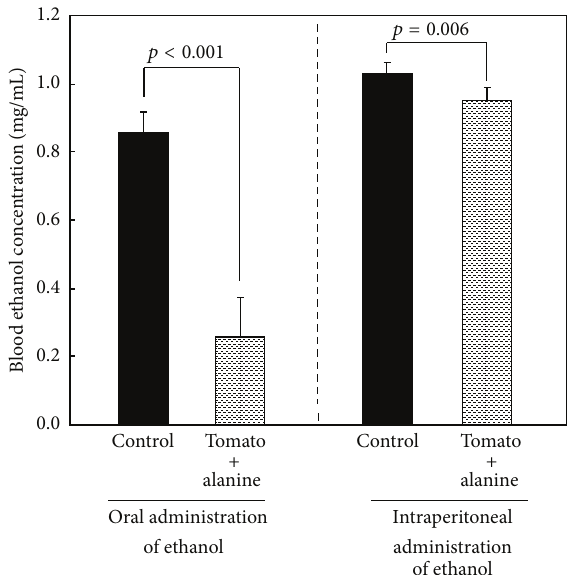
Figure 6: Blood ethanol concentrations 1h after oral or intraperi- toneal administration of 1.0 g/kg of ethanol (Experiment 4). Thirty minutes later, the rats received 20 mL/kg of either tomato juice with 5.0% alanine or water (control) orally. Results are expressed as mean and standard deviation ( 𝑛 = 6 ). Blood ethanol concentrations between control and tomato + alanine group were compared using the Student 𝑡